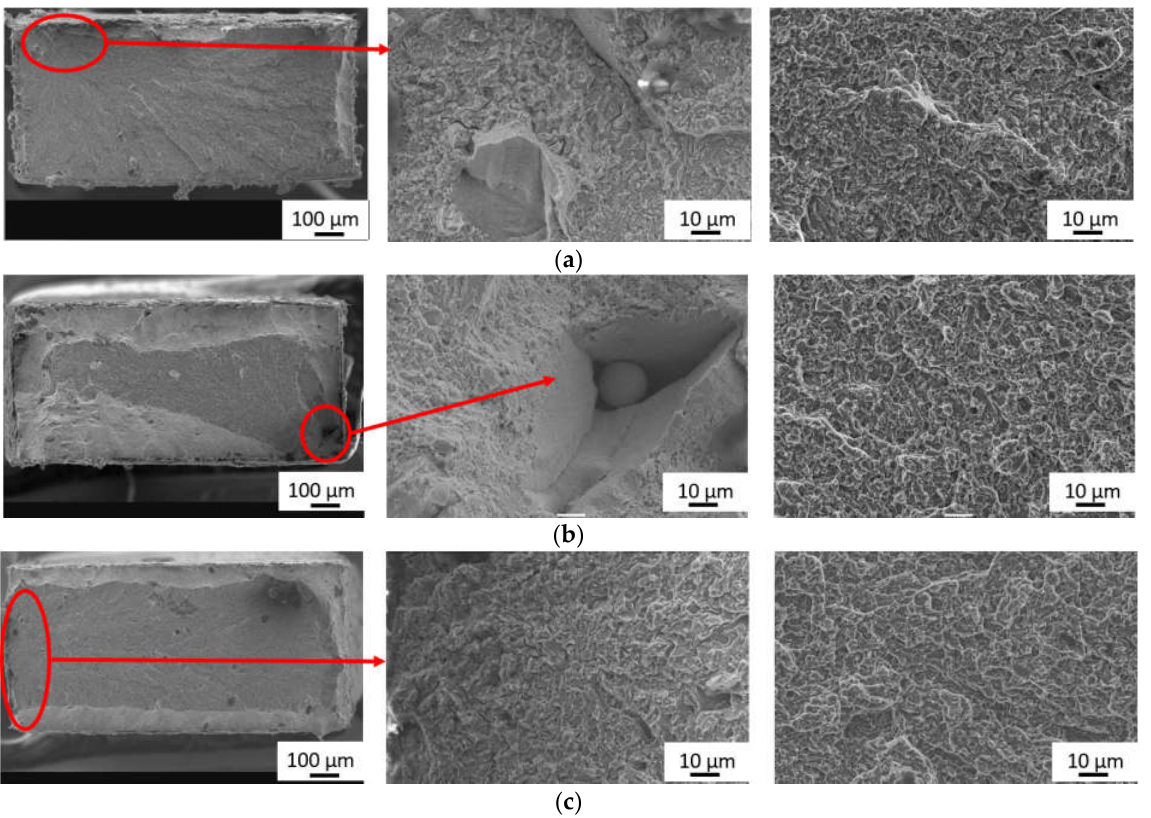
Figure 7. Fracture surfaces of H13 steel after tensile test for cooling rate of: ( a ) 100 °C/s; ( b ) 10 °C/s; ( c ) 1 °C/s.